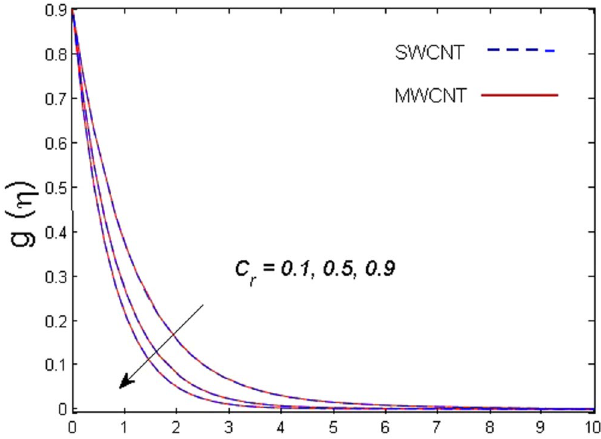
Figure 12. Outcome of C r on η g ( ) .